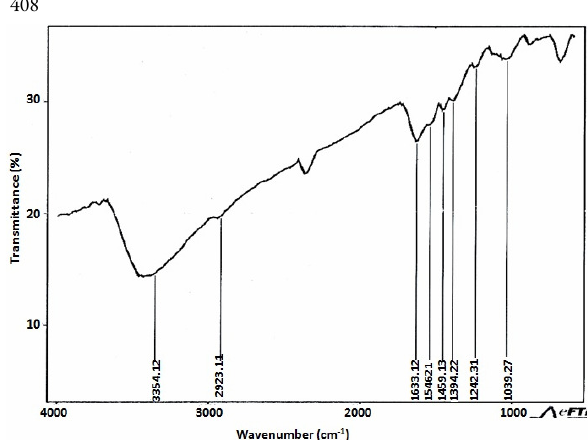
Fig. 3. FTIR spectrum of the biosynthesized AgNPs